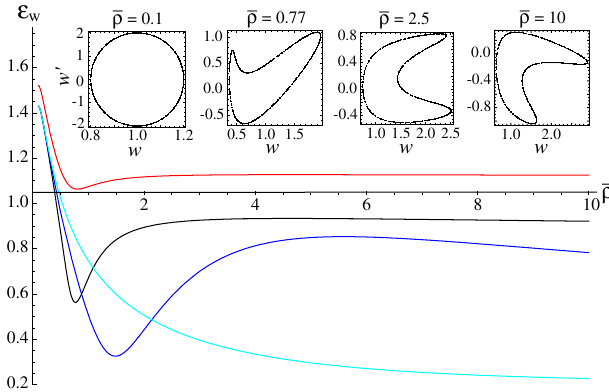
FIG. 3. (Color) Comparison of emittance in the booster linac of FIG. 2. (Color) Emittance compensation in linacs with constant the SPARC photoinjector computed using HOMDYN simulation focusing. The red curve is the rms bunch emittance computed (blue) and the universal envelope equation (cyan) excluding the with the universal equation and Eq. (18). The other three curves thermal emittance. The small difference in the second cavity is are rms envelope-phase-space emittance from, respectively, the due to the drift space between the two cavities in the booster. The exact universal equation (black), the space-charge-dominated emittance beyond the booster is also shown assuming the same (blue). Insets theory (cyan), and linear perturbation around W accelerating structures. Thermal emittance is included in the red (cid:3) are phase-space distributions at the beginning and the end, as curve using Eq. (18) and in the magenta curve using a simple well as at locations with the minimum and maximum emittances. quadratic